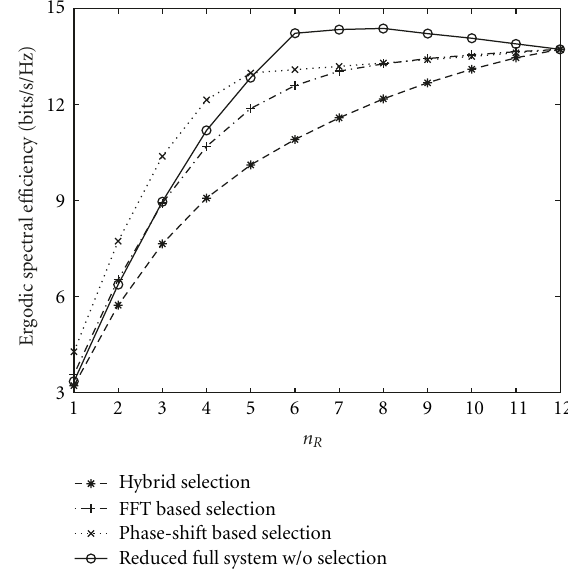
Figure 8: Ergodic spectral e ffi ciency of a compact MIMO system with antenna selection, where M = 5 and N = 12.